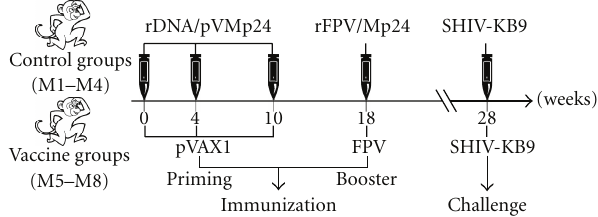
Figure 2: Immunization and challenge schedule. rDNA: recombi- nant DNA; rFPV: recombinant